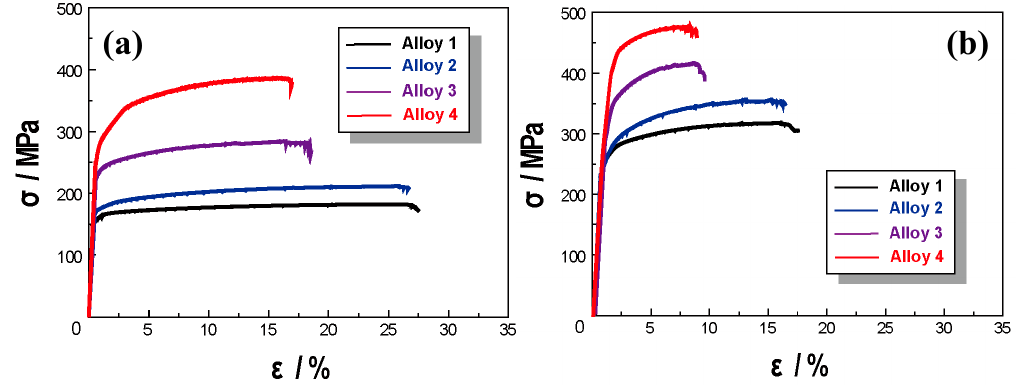
Figure 10. Tensile curves of the alloys in different heat-treatment states: ( a ) as-quenched, ( b ) peak-aged.